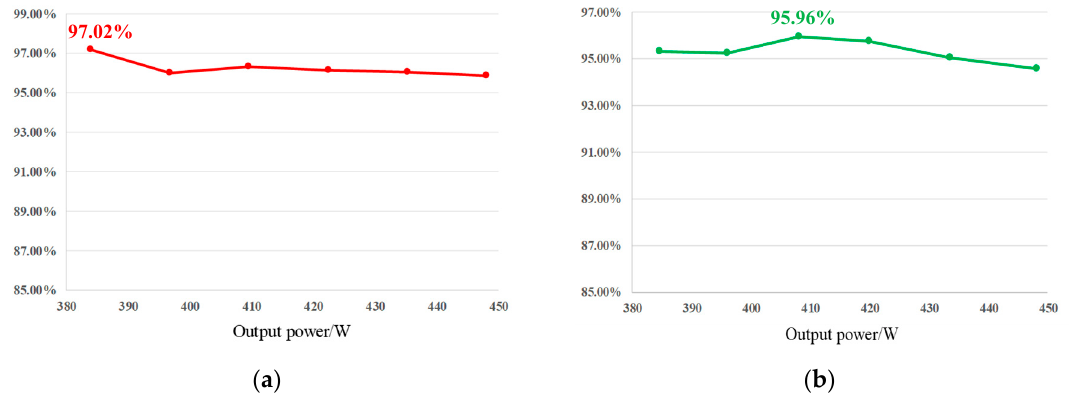
Figure 12. Efficiency curves of the converter. ( a ) Forward mode; ( b ) reverse mode.